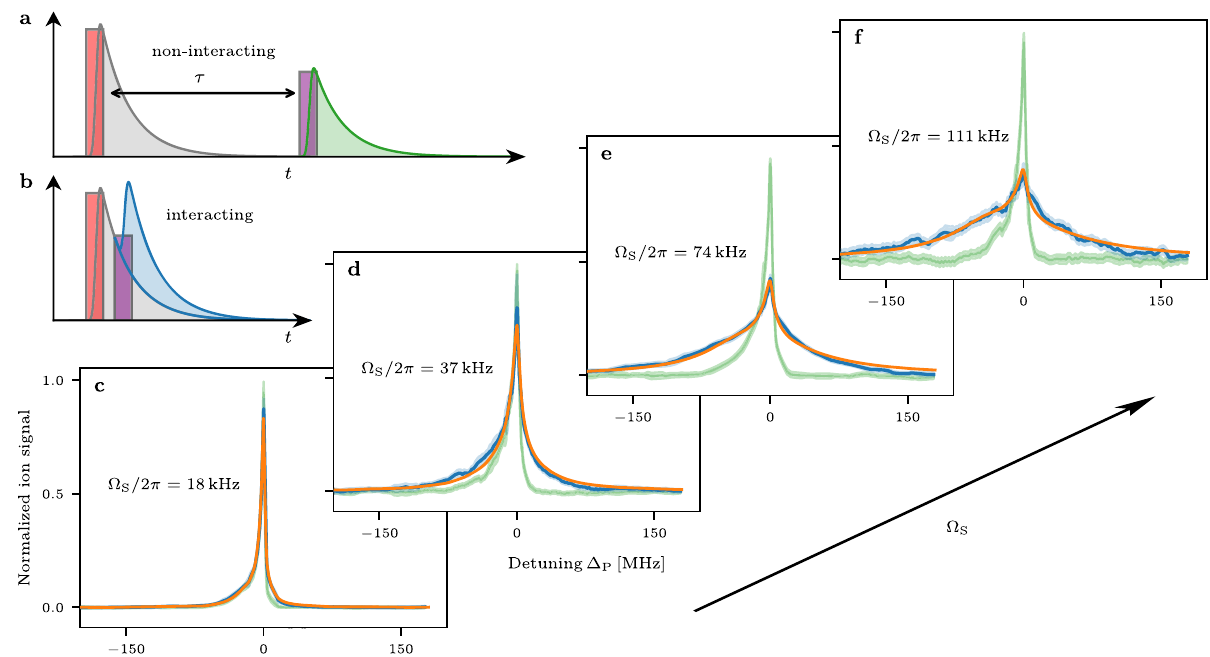
Fig. 2 Spectroscopy of dipole – dipole coupled many-body Rydberg systems. a , b illustrate the pump – probe excitation scheme with delay τ in the non- interacting ( a ) and interacting case ( b ). The fi rst pulse (red) creates seed excitations in the j 51S 1 = 2 i -state. The second pulse (purple) excites atoms to the j 51P i -state. c – f Spectra for the excitation of the j 51P i -state after the creation of different numbers of initial seeds in the j 51S 3 = 2 3 = 2 Rabi frequencies Ω S ( c ) 2 π × 18 kHz, ( d ) 2 π × 37 kHz, ( e ) 2 π × 74 kHz, ( f ) 2 π × 111 kHz. The interacting ( τ = 1 μ s, blue) and non-interacting ( τ = 300 μ s, green) spectra in ( c – f ) are obtained by integrating the blue and green shaded area of the time-resolved signals in ( a ) and ( b ) for each detuning Δ P , respectively. The shaded areas in ( c – f ) denote the standard error of the mean. In the interacting case ( b ), the signal from the probe pulse (blue shaded area) is isolated by subtracting the pump signal (gray shaded area) from the non-interacting case ( a ) (see Supplementary Note 3 for details). The results of the numerical model are shown as orange lines. We extract average coherently coupled seed excitation numbers (cid:2) n of ( c ) 0.6, ( d ) 2.4, ( e ) 5.0, and ( f ) b). In the fi rst step a variable number of atoms is brought into the (cid:4) (cid:5) (cid:4) # -state (labeled as “ seeds ” ) and a subsequent pulse excites on the (cid:4) (cid:5) (cid:4) -state. The excitation order of one ground state atom into the " ; m ¼ 1 = 2 i is realized by a to the spin-down state j #i ¼ j 51S 1 = 2 J 1 μ s long resonant two-photon pulse. The average number (cid:2) n and